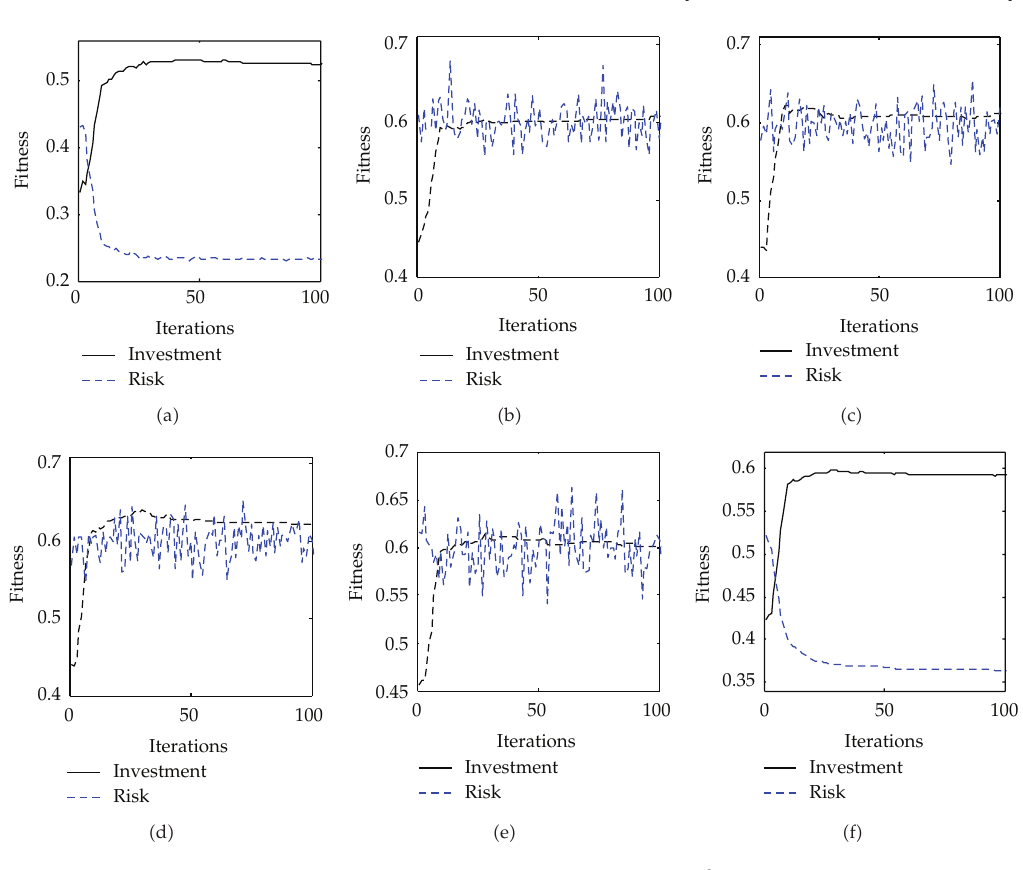
Figure 15: The base-level search process based on PS 2 O and PSO.